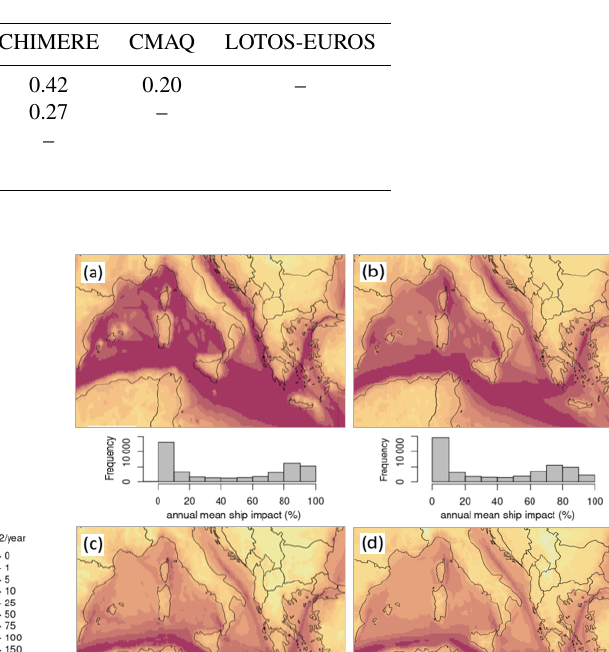
Table 8. Correlation between models for the whole domain (all grid cells) based on daily data for O 3 total dry deposition.